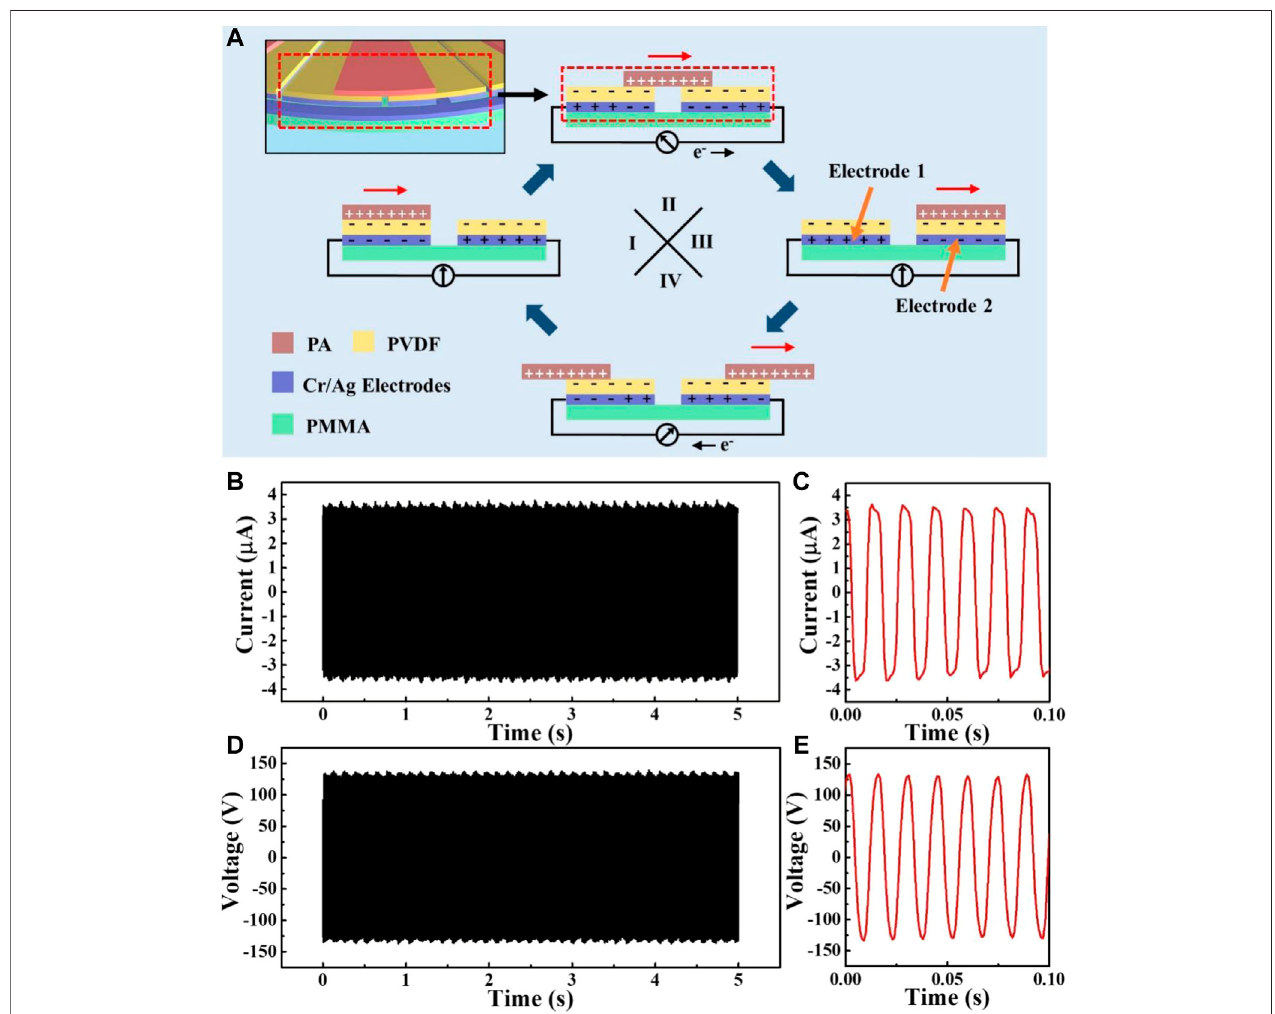
FIGURE 2 | Output of the D-TENG. (A) Schematic diagram of the working mechanism of the D-TENG. (B) Output current of the D-TENG. (C) Enlarged view of D-TENG ’ s output current. (D) Output voltage of the D-TENG. (E) Enlarged view of D-TENG ’ s output voltage.